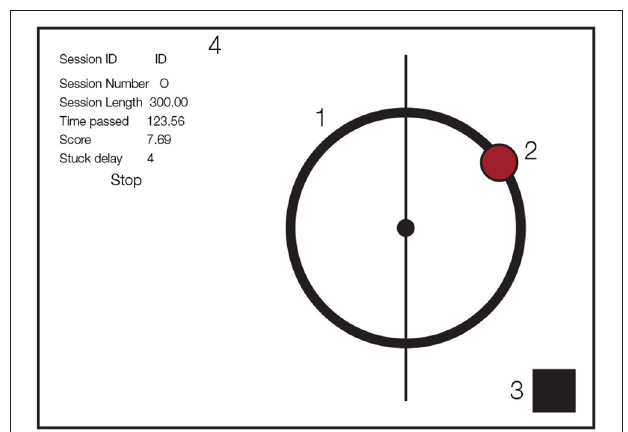
FIGURE 1 | Schematic of game design on the tablet. (1) Circular track, (2) ball, (3) flashing rectangle indicating experimental events (covered by luminance sensor), (4) text box for experiment monitoring (only used by